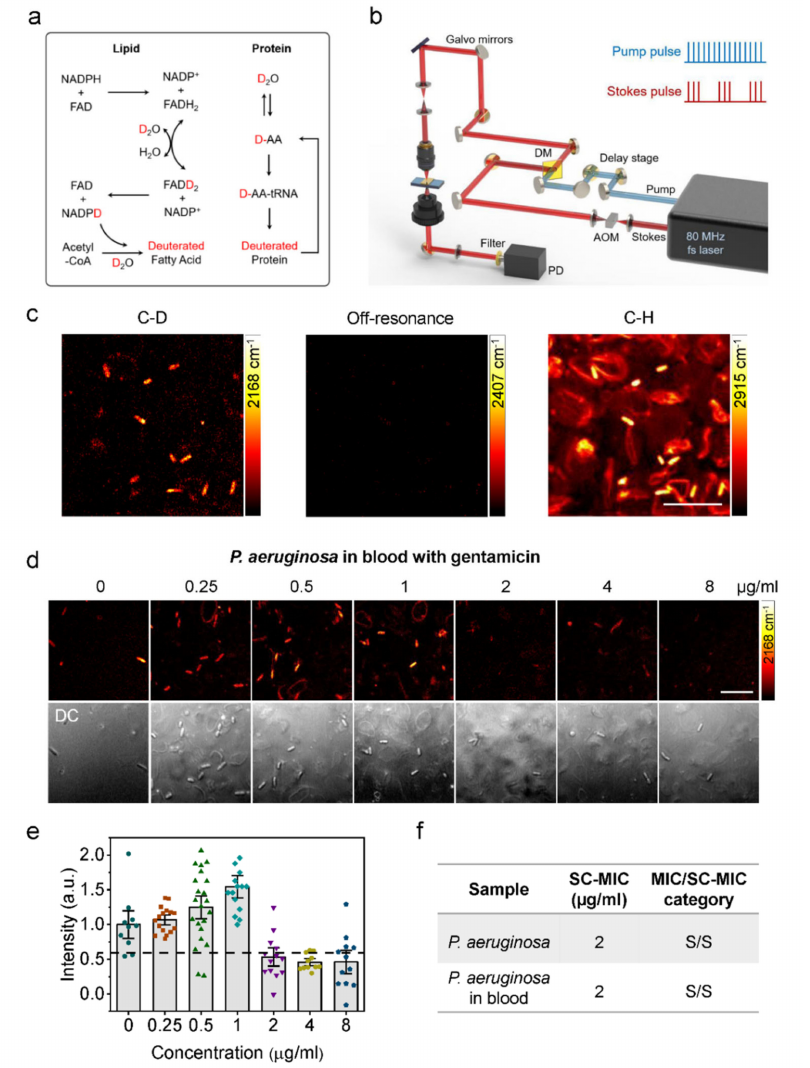
Figure 4. Rapid AST by SRS imaging of D 2 O metabolic incorporation. ( a ) Scheme for D 2 O labeling of lipid and protein. ( b ) SRS setup. AOM: acousto-optic modulation. DM: dichroic mirror. PD: photodiode. ( c ) SRS images at C–D, off-resonance, and C–H of bacteria in blood after 1-h culture in D 2 O containing medium. Scale bar: 10 µ m. ( d ) SRS and corresponding transmission images of P. aeruginosa in blood after 1-h culture in D 2 O containing medium with the addition of serially diluted gentamicin. Scale bar: 10 µ m. ( e ) Statistical analysis of C–D intensity in bacteria in ( d ). ( f ) Comparison of SC-MIC and susceptibility category for P. aeruginosa isolates and P. aeruginosa in blood. S: sensitive. Reprinted with permission from reference